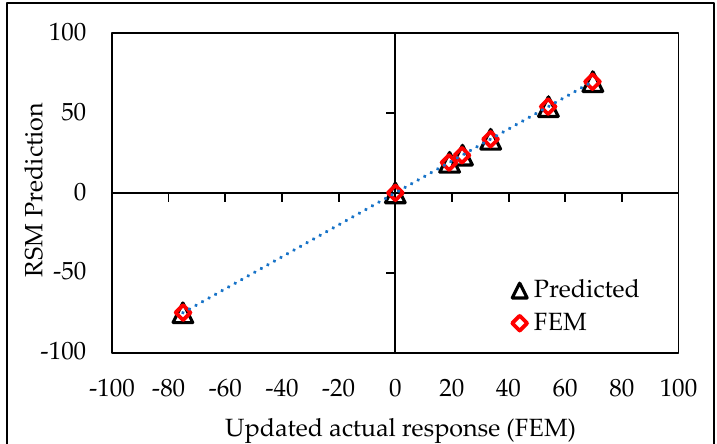
Figure 11. Predicted value vs. updated actual numerical response (FEM) plot.